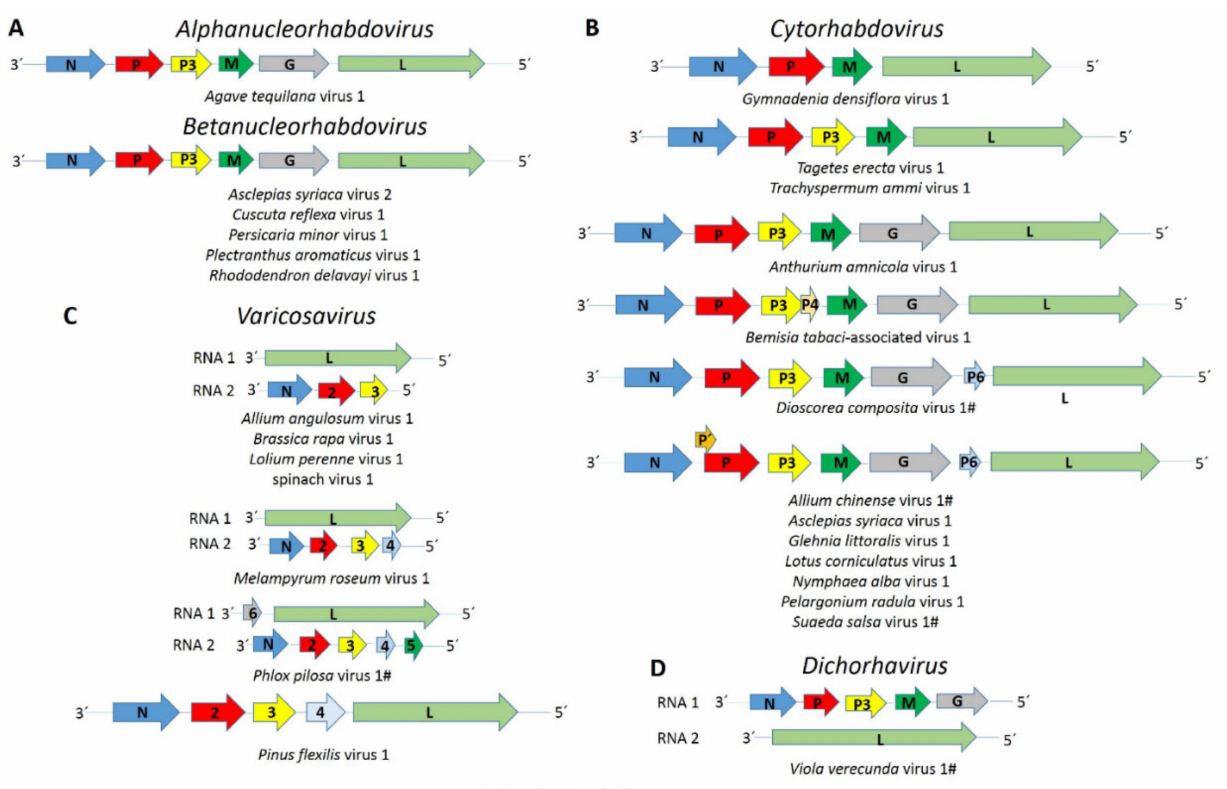
Figure 1. Diagrams depicting the genomic organization of each ( A ) alpha- and betanucleorhabdovirus, ( B ) cytorhabdovirus, ( C ) varicosavirus and ( D ) dichorhavirus sequence assembled in this study. Abbreviations: N, nucleoprotein coding sequence (CDS); P, phosphoprotein CDS; P3, putative cell-to-cell movement protein CDS; M, matrix protein CDS; G, glycoprotein CDS; L, RNA-dependent RNA polymerase CDS.